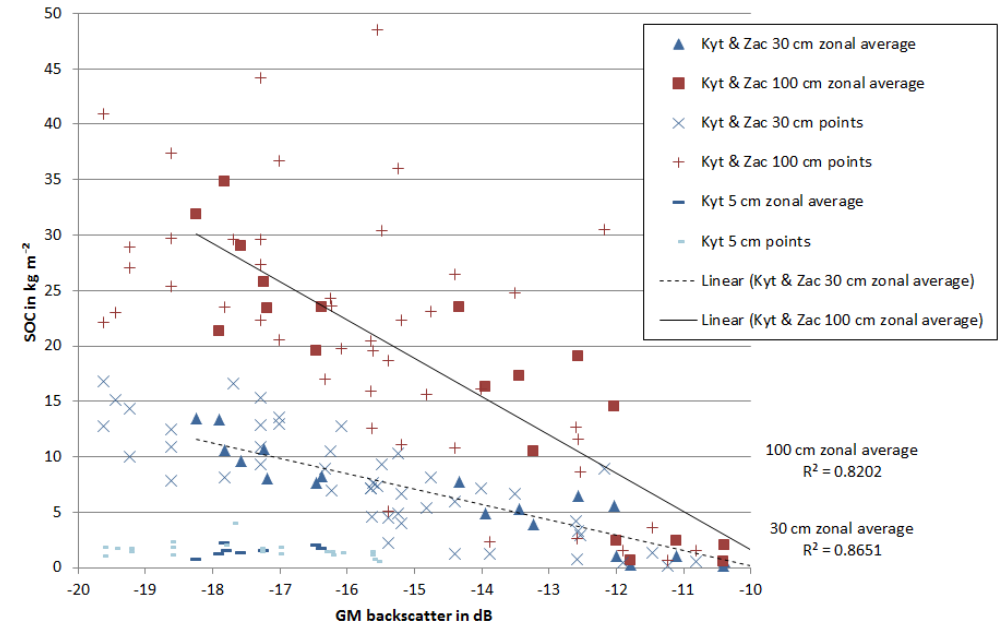
Figure 4. SOC from land cover classifications and pedon data (points) for all depths versus backscatter from ENVISAT ASAR GM, for Kytalik (Kyt) and Zackenberg (Zac). Five-centimetre data are only available for Kytalyk.